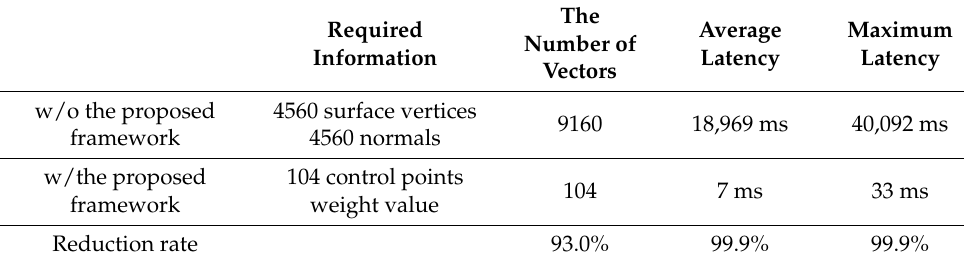
Table 2. Average and maximum latency comparison and reduction rate in the VE training